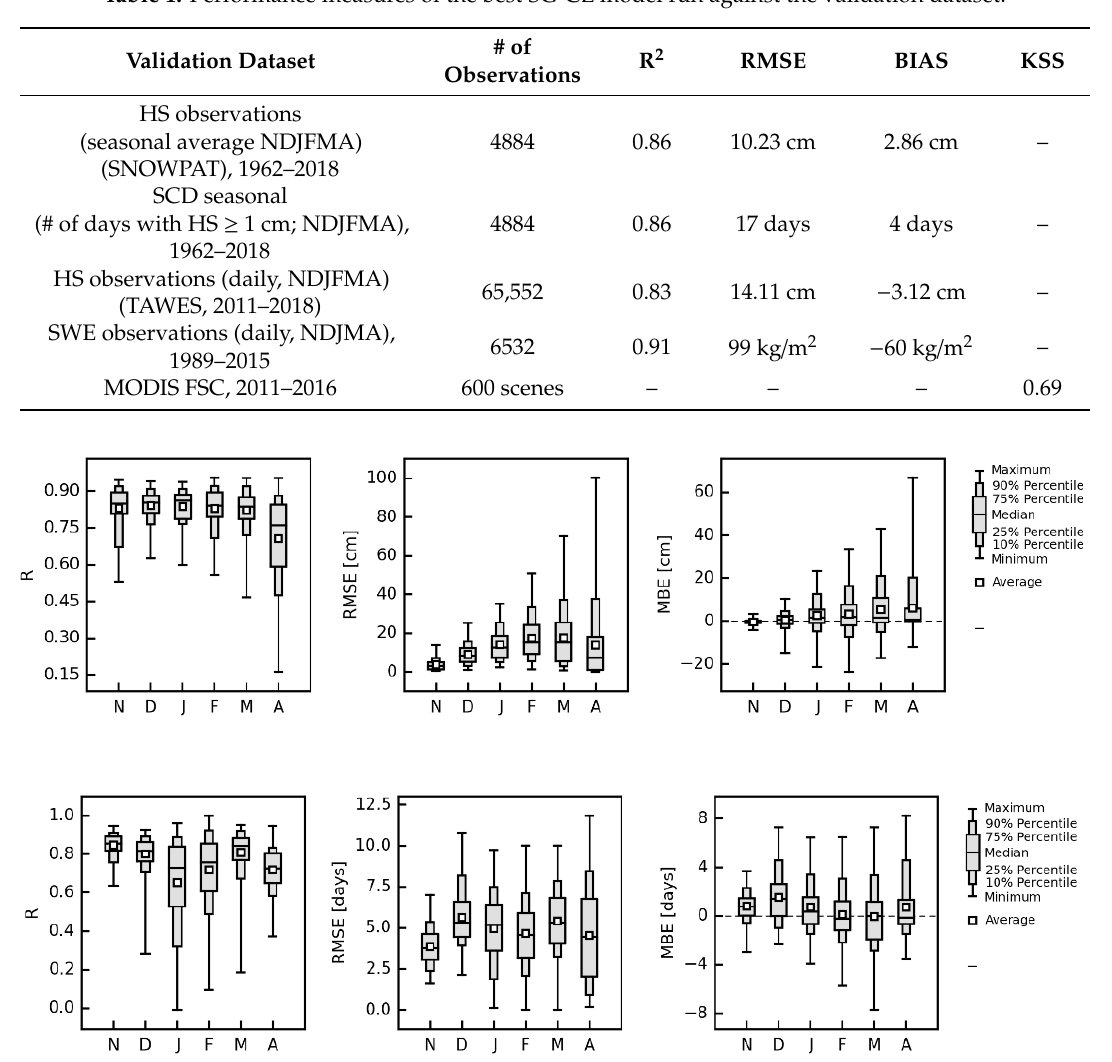
Table 1. Performance measures of the best SG-CL model run against the validation dataset.